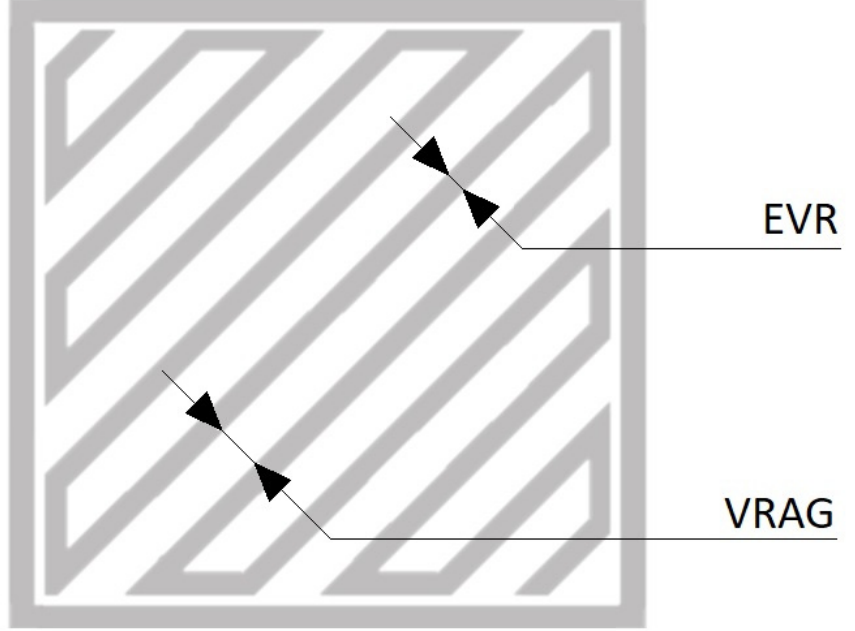
Figure 1. Schematization of enhanced visible rasters (EVR) and visible raster air gap (VRAG).